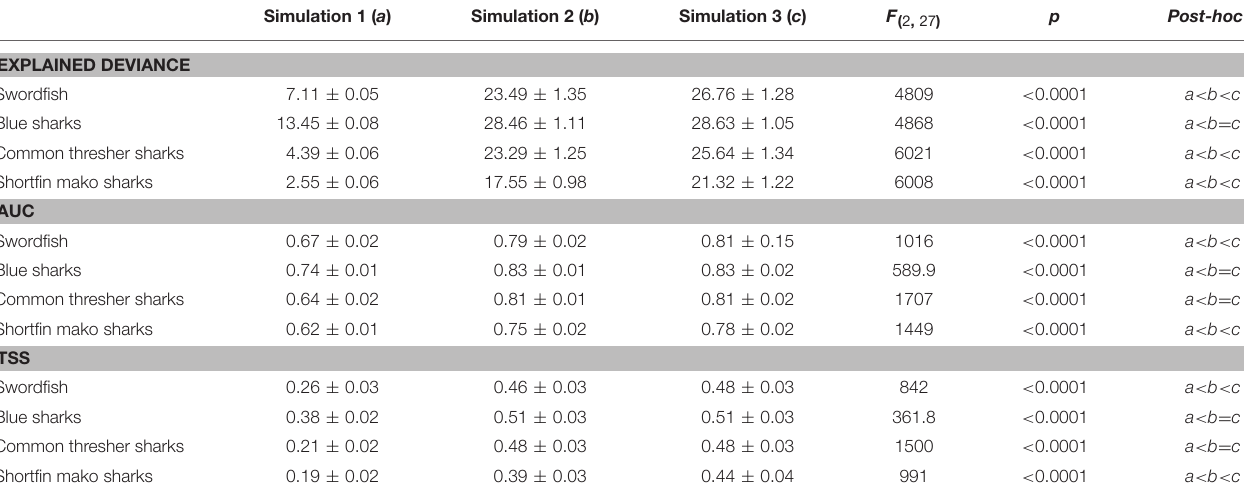
TABLE 3 | ANOVA and Tukey HSD post-hoc results from species distribution model simulation